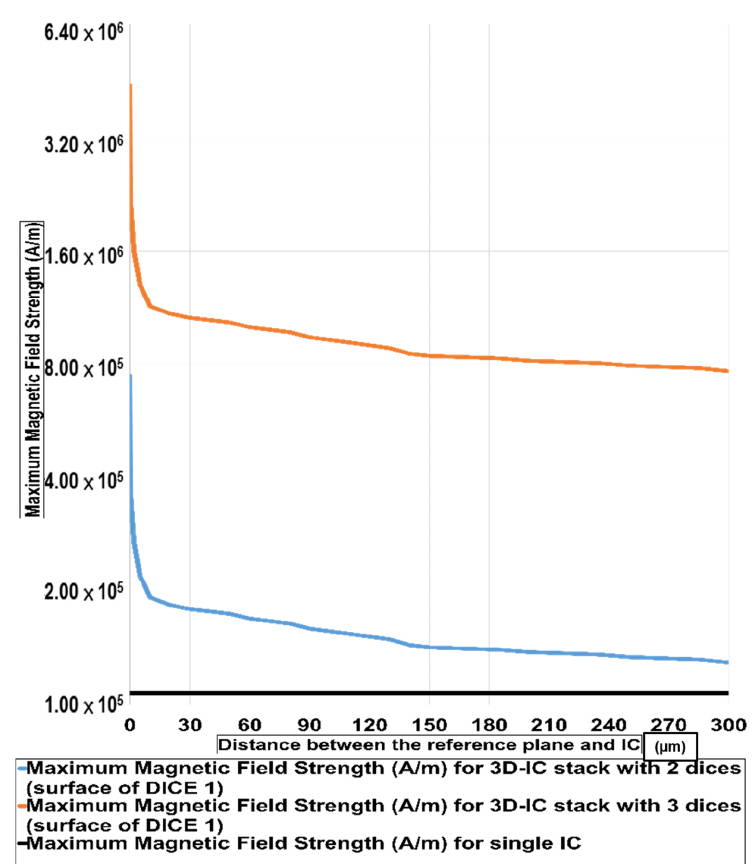
Figure 12. Maximum magnetic field strength versus the distance between the reference plane and topmost layer of 3D-IC at 3 GHz operating frequency.